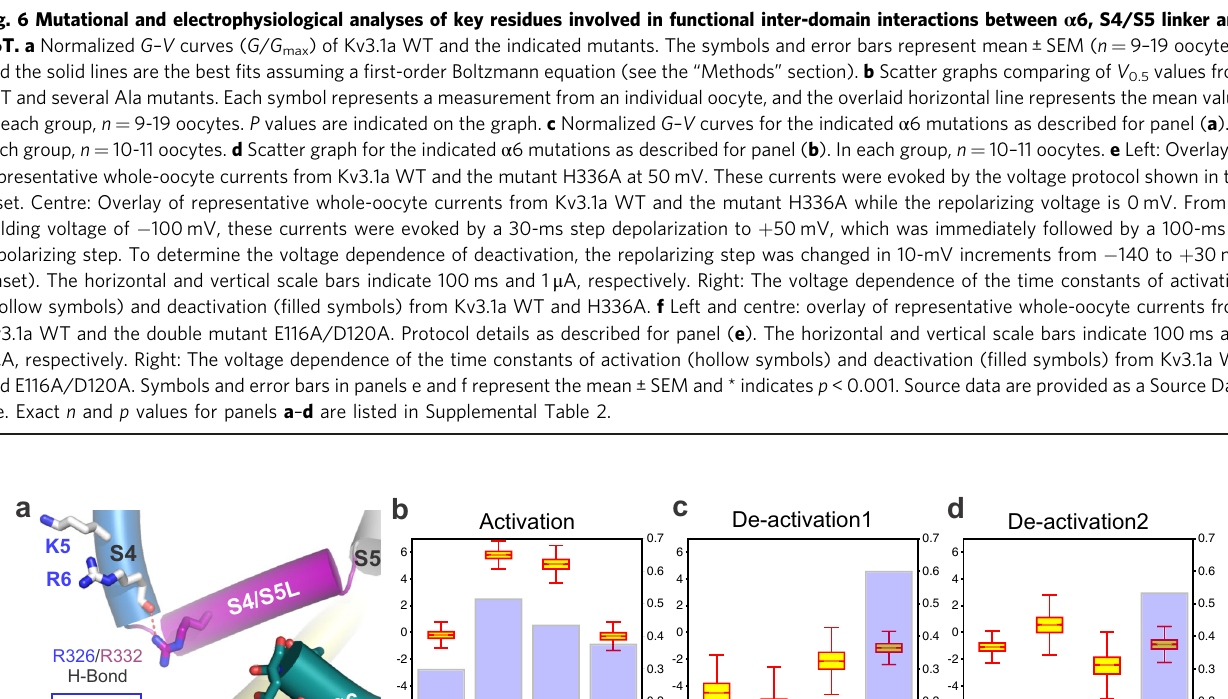
Fig. 7 MD simulations of S4 voltage sensor movement during activation/deactivation reveal a correlation with E116/K449 salt bridge stability. a Cartoon representation of the S4 – S5/S6T contact region in Kv3.1a, showing the positions of the R326/R332 H-bond and the salt bridge E116A/K449 between α 6 in the T1 domain and S6T. b Comparison of the Z-position of the R4 dating charge relative to the CTC (boxplot) and the stability of the E116/ K440 (violet bars) for each subunit under activating conditions ( + 300 mV). Data calculated from 750ns (12,000 frames) following the movement of R4 Arginine (SI Fig. S15). The salt-bridge was assumed to form in frames with distance between the heavy atoms of the residues being <3.3 Å. Boxes span the interquartile range and whiskers extend up to 1.5 times this range. c , d Comparison of the Z-position of the R4 gating charge relative to the CTC (boxplot) and the stability of the E116/K440 (violet bars) for each subunit under deactivating conditions ( − 650 mV) from two independent trajectories. Data calculated from 750 ns (12,000 frames) following the movement of R4 arginine. The salt-bridge was assumed to form in frames with distance between the heavy atoms of the residues being <3.3 Å. Boxes span the interquartile range and whiskers extend up to 1.5 times this range. Source data for b – d are provided as a Source Data fi